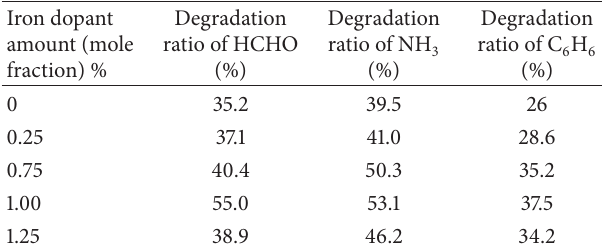
Table 1: Degradation ratios of individual formaldehyde, ammonia, and